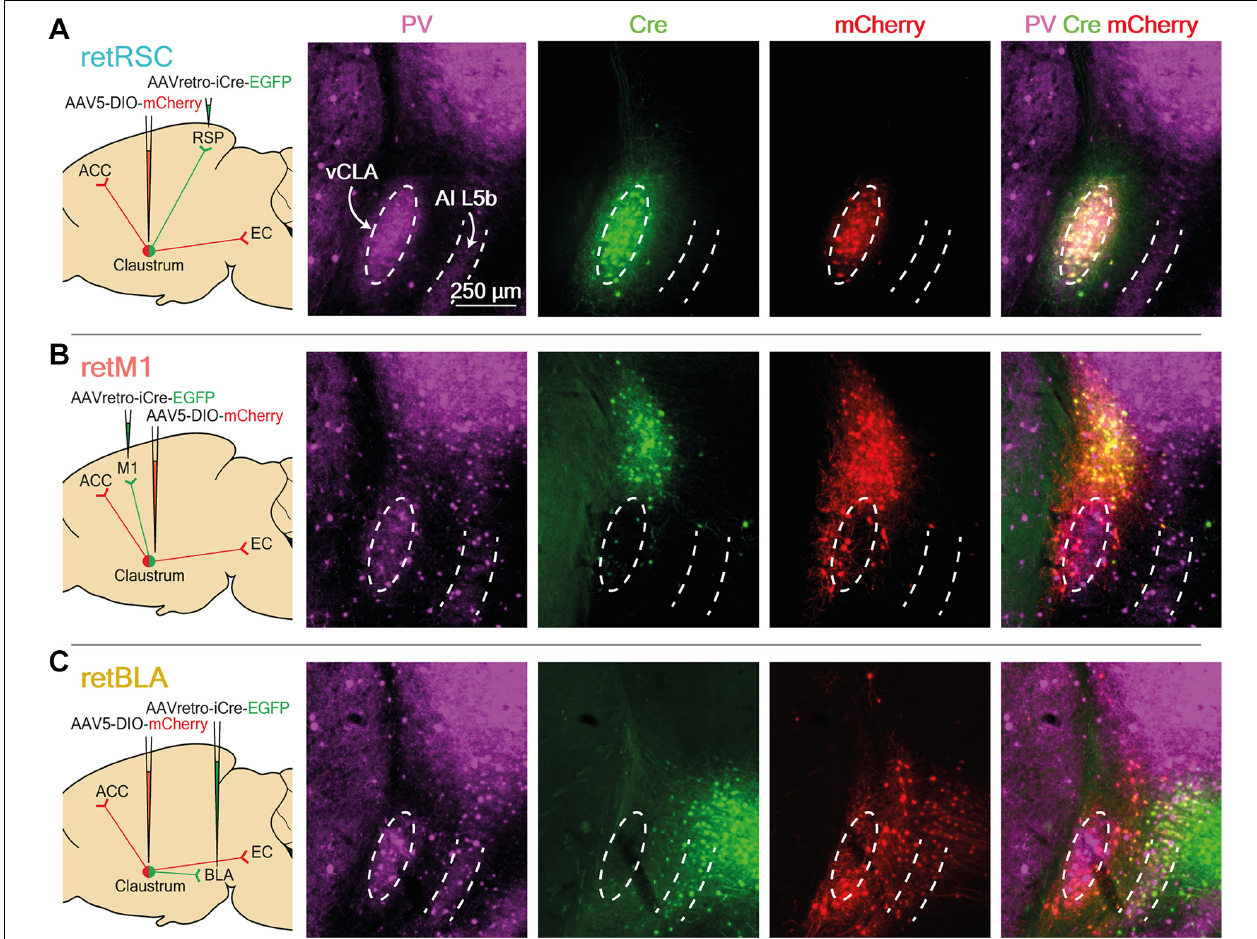
FIGURE 1 | Neurons projecting to RSC, BLA, and M1 reside in distinct topological zones within the claustrum (CLA). (A) Images of RSC-projecting CLA neurons (retRSC), (B) BLA-projecting CLA neurons (retBLA), and (C) M1-projecting CLA neurons (retM1). (Left column) Viral strategy to target projection-defined claustrum neurons and map output networks. (2nd-4th columns) Parvalbumin (PV) staining and resultant viral expression of Cre and mCherry. Dotted white ellipses demarcate the ventral CLA core (vCLA) while dotted white lines demarcate layer 5b of the agranular insula, (AI L5b) as indicated by PV immunohistochemistry. Cre expression produced by retrograde AAV injected into the initial targets (RSC, M1, and BLA), as indicated by EGFP-labelled neurons that project to the initial targets. Cre-dependent mCherry expression in CLA neurons used for network mapping. (Right column) Merged images of all three fluorescence